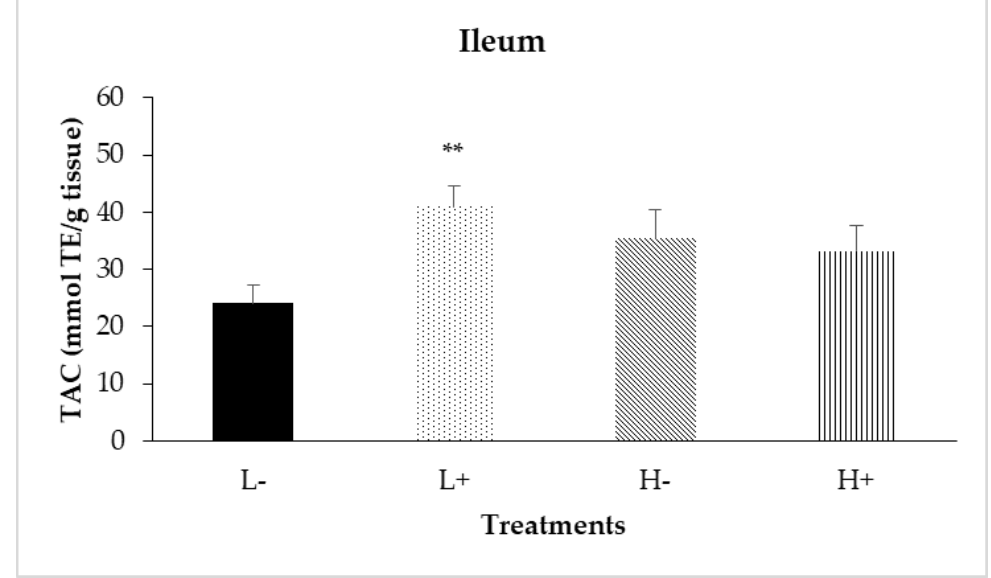
Figure 5. Interaction effects of diet type and phytogenic feed additive (PFA) supplementation on total antioxidant capacity of ileal mucosa of 42-day-old broilers. Columns indicate treatments means + SD, and the asterisk(s) denotes statistical difference ( P D×P = 0.007).